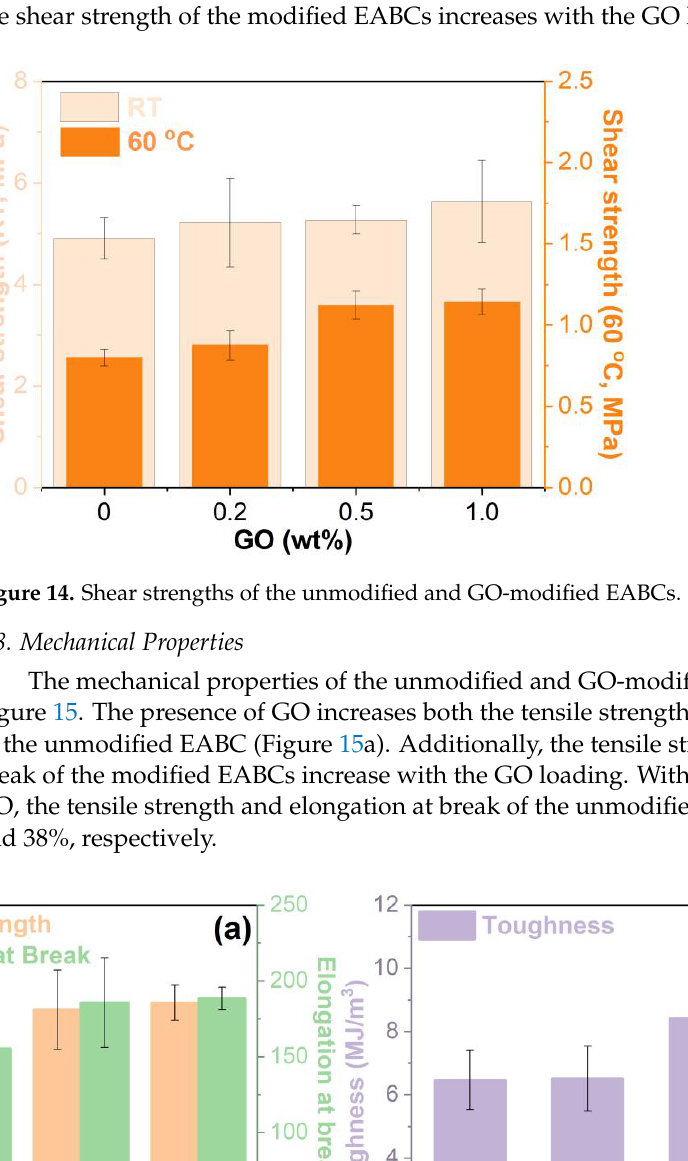
Figure 13. Failure surfaces of the unmodified and GO-modified EABCs on steel plates after pull-off tests at room temperature ( a ) and 60 °C ( b ).